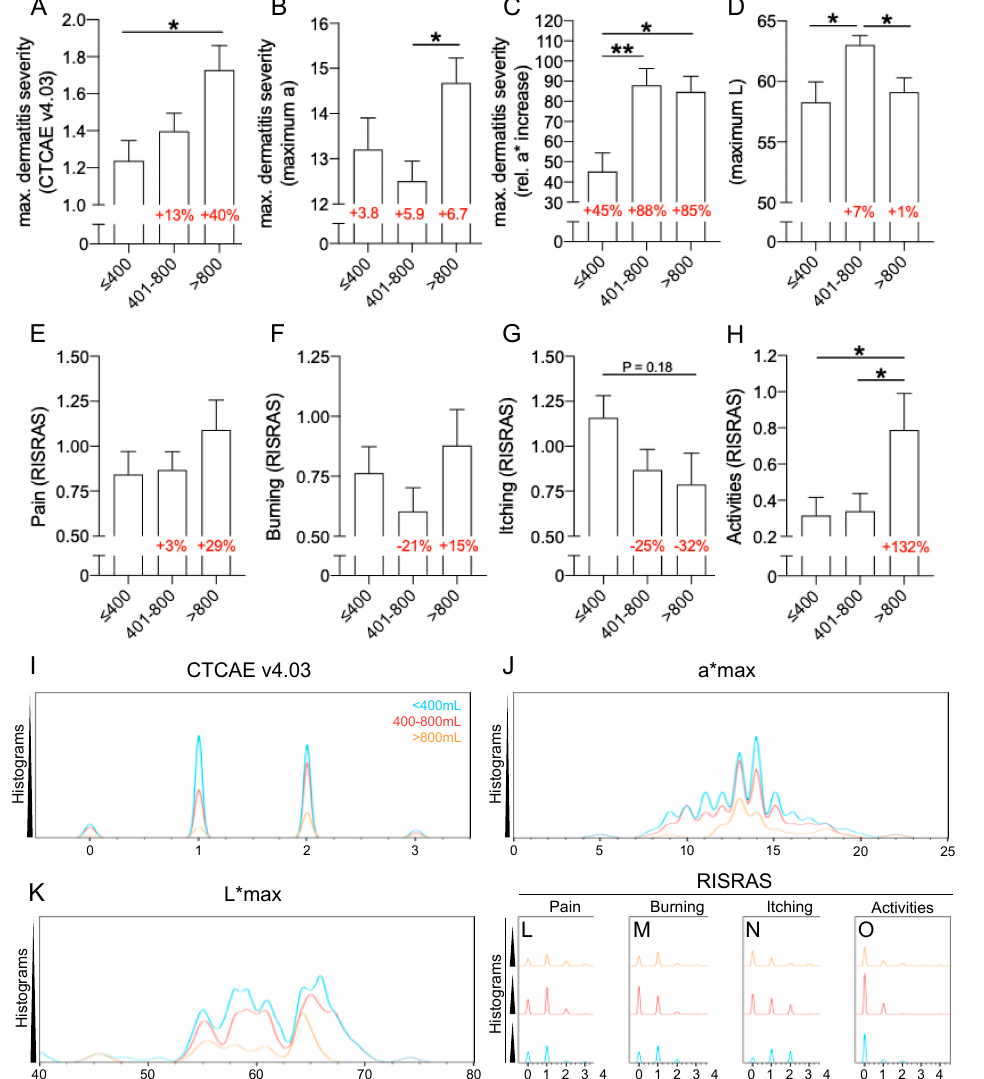
Figure 2. Breast volume is a positive risk factor for severe RID. ( A ) Maximum dermatitis severity was assessed by physicians according to CTCAE v4.03 in relation to di ff erent breast volumes. Percentages in red indicate the relative increase to the dermatitis severity for patients with a breast volume of < 400 mL. ( B ) Maximum dermatitis severity is measured by spectrophotometry as maximum a* values in relation to di ff erent breast volumes. Numbers in red indicate the absolute increase to baseline a* values. ( C ) Maximum dermatitis severity is measured by spectrophotometry as relative a* value-increase (maximum to baseline) in relation to di ff erent breast volumes. Numbers in red indicate the relative increase to baseline a* values. ( D ) The lightness of the skin during RID enumerated by absolute L* maximum values obtained by SP. Red numbers indicate the alteration relative to patients with small breasts. ( E – H ) Subjective RISRAS assessment of RID related symptoms. ( E ) Pain ( F ) Burning ( G ) Itching ( H ) Reduction in everyday life activities. Red numbers indicate the alteration relative to patients with small breasts. ( I – O ) Distribution pattern analyses according to breast size < 400 mL (light blue), 400–800 mL (red) and > 800 mL (orange). ( I ) Visual CTCAE v4.03 grading ( J ) Maximum a* value ( K ) Maximum L* values ( L ) Pain assessed by RISRAS. ( M ) Burning assessed by RISRAS ( N ) Itching assessed by RISRAS ( O ) Reduction in everyday life activities. One-way-ANOVA has been conducted for significance detection with * for p < 0.05, ** for p <